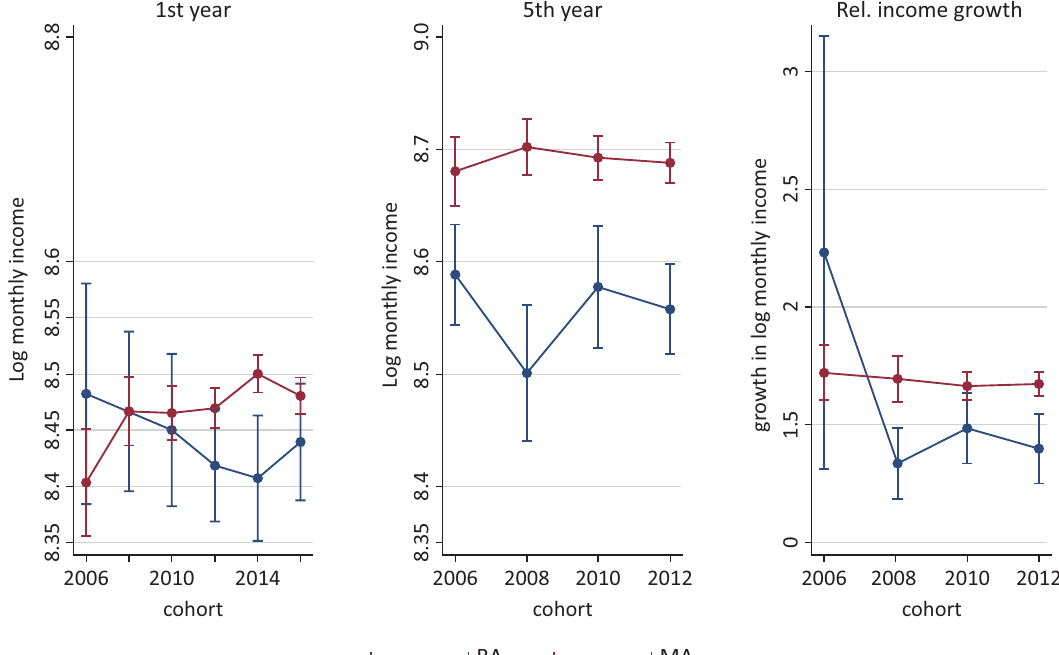
Figure 2. Linear predictions of interactions of university degree and cohort on gross monthly income (log) for women in the first and fifth year after graduation and their relative income growth. Data: SGS, own calculations. Note: See Table A6 in Appendix for further